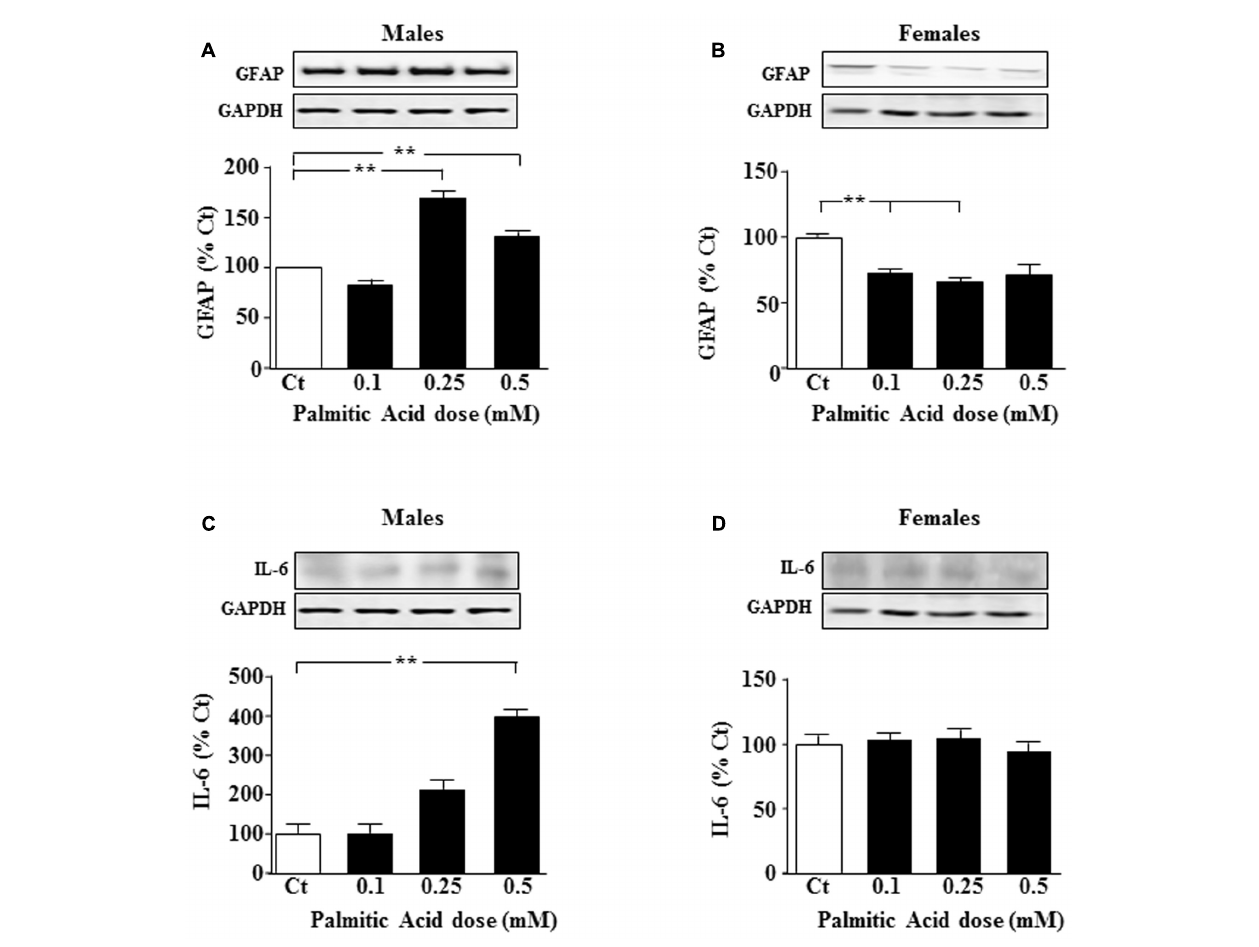
FIGURE 1 | Palmitic acid (PA) dose-response curve at 24 h. Astrocyte cultures were treated with doses of 0.1, 0.25, and 0.5 mM of PA. Immunoblots were probed with antibodies toward glial fibrillary acidic protein (GFAP) in male (A) , and female (B) astrocytes and interleukin 6 (IL-6) in male (C) and female (D) astrocytes. The average of three independent assays performed in duplicate is shown. Statistical significance: ∗∗ p <